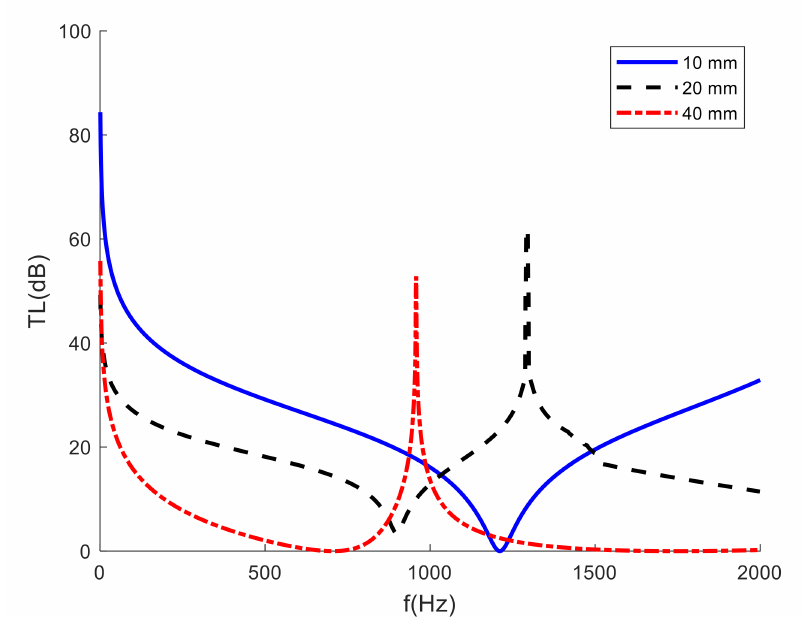
Figure 12. STL curves for different film